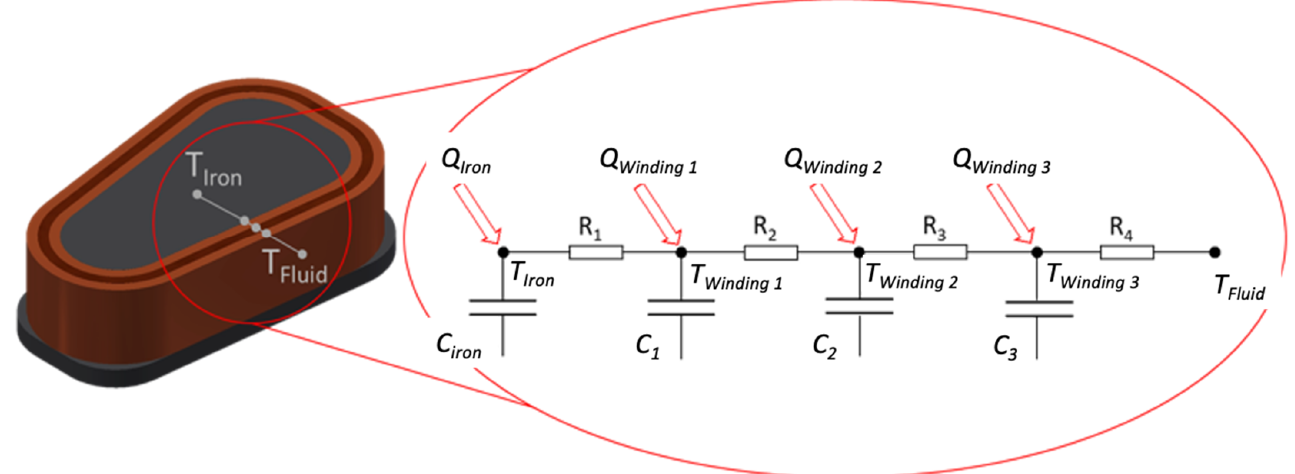
Figure 8. LP thermal model with nodes on each winding layer. (Insert) Thermal resistance network. The parameters Q iron and Q winding are the heat loads supplied to the iron and the winding nodes, respectively. C 1 –C 4 are the thermal capacity at each node. R 1 –R 3 are the thermal resistances between the layers. R 4 is the convective thermal resistance.